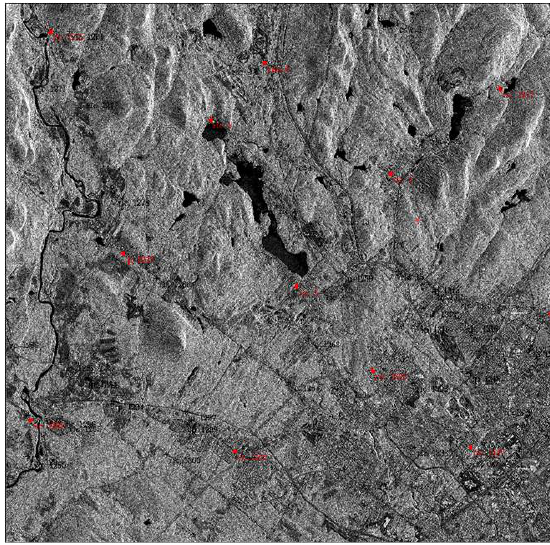
Figure 4: GCPs distribution on RADARSAT-2 imagery